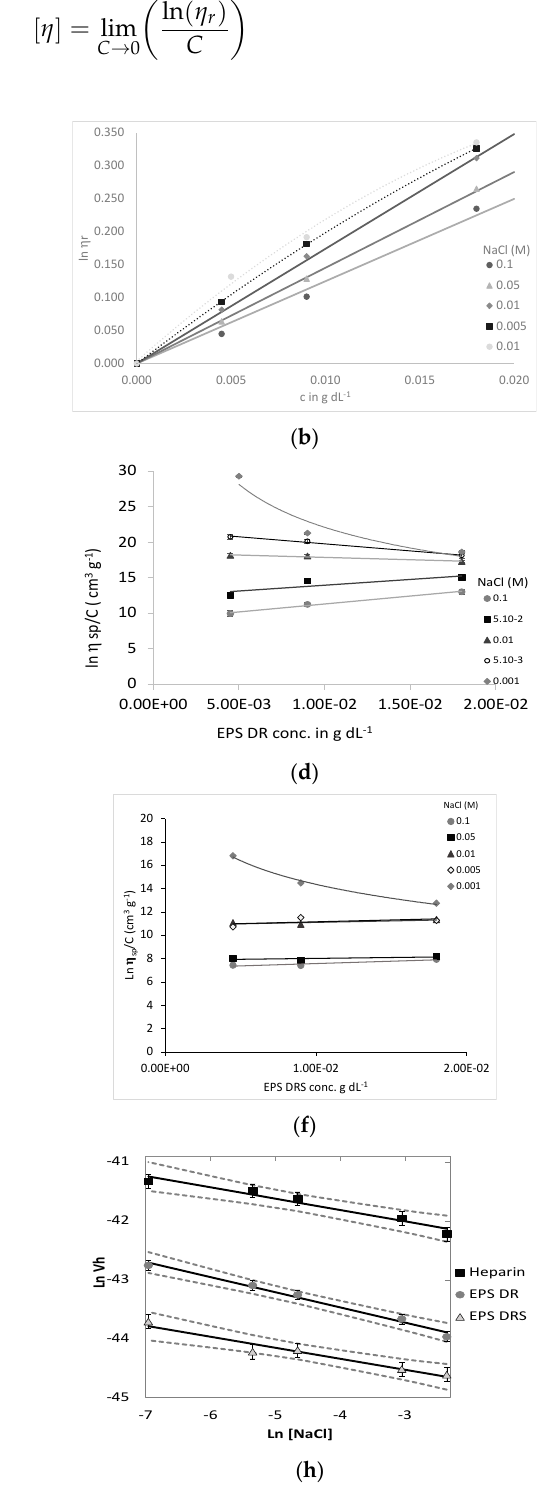
Figure 5. Relative viscosity η r and intrinsic viscosity [ η ] at different ionic strength (NaCl) of ( a , c ) heparin, ( b , d ) EPS-DR and ( e , f ) EPS-DRS. Concentrations of EPS-DR, -DRS and heparin: 4.5, 9, and 18 mg mL − 1 (additional concentration at 36 mg mL − 1 for heparin). NaCl concentrations: 0.1 (circles), 5 × 10 − 2 (squares), 10 − 2 (triangles), 5 × 10 − 3 (empty diamonds), 10 − 3 mol L − 1 (diamonds); ( g ) Intrinsic viscosity and ( h ) hydrodynamic volume of heparin (squares) and EPS-DR (circles) and -DRS (triangles) at different NaCl concentrations (in logarithmic scale).